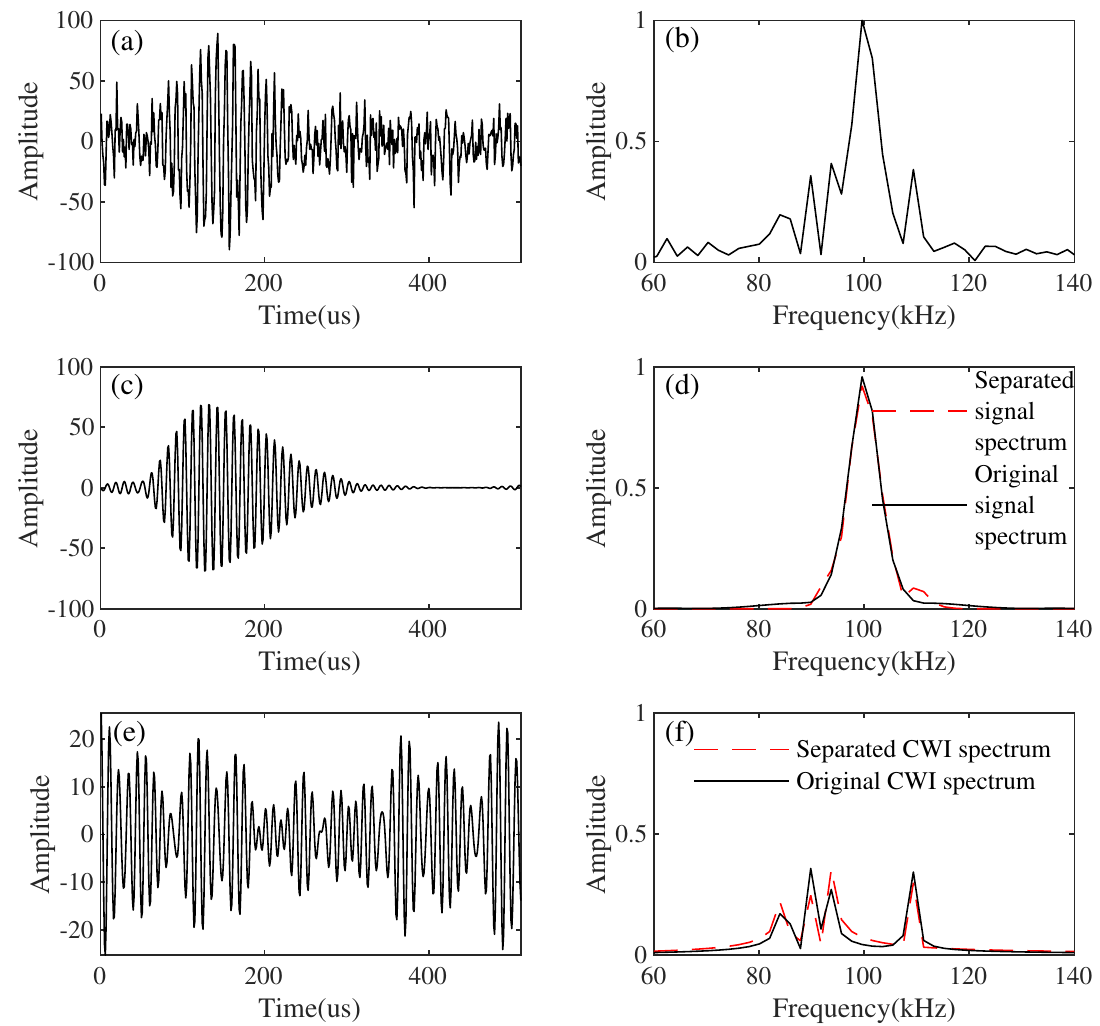
Figure 8. Results of separation by the proposed method (white noise: 5 dB). ( a ) Simulated synthetic signal. ( b ) Spectrum of simulated synthetic signal. ( c ) Separated Loran-C signals. ( d ) The spectrum of the separated Loran-C signal. ( e ) Separated CWI. ( f ) The spectrum of the separated CWI.